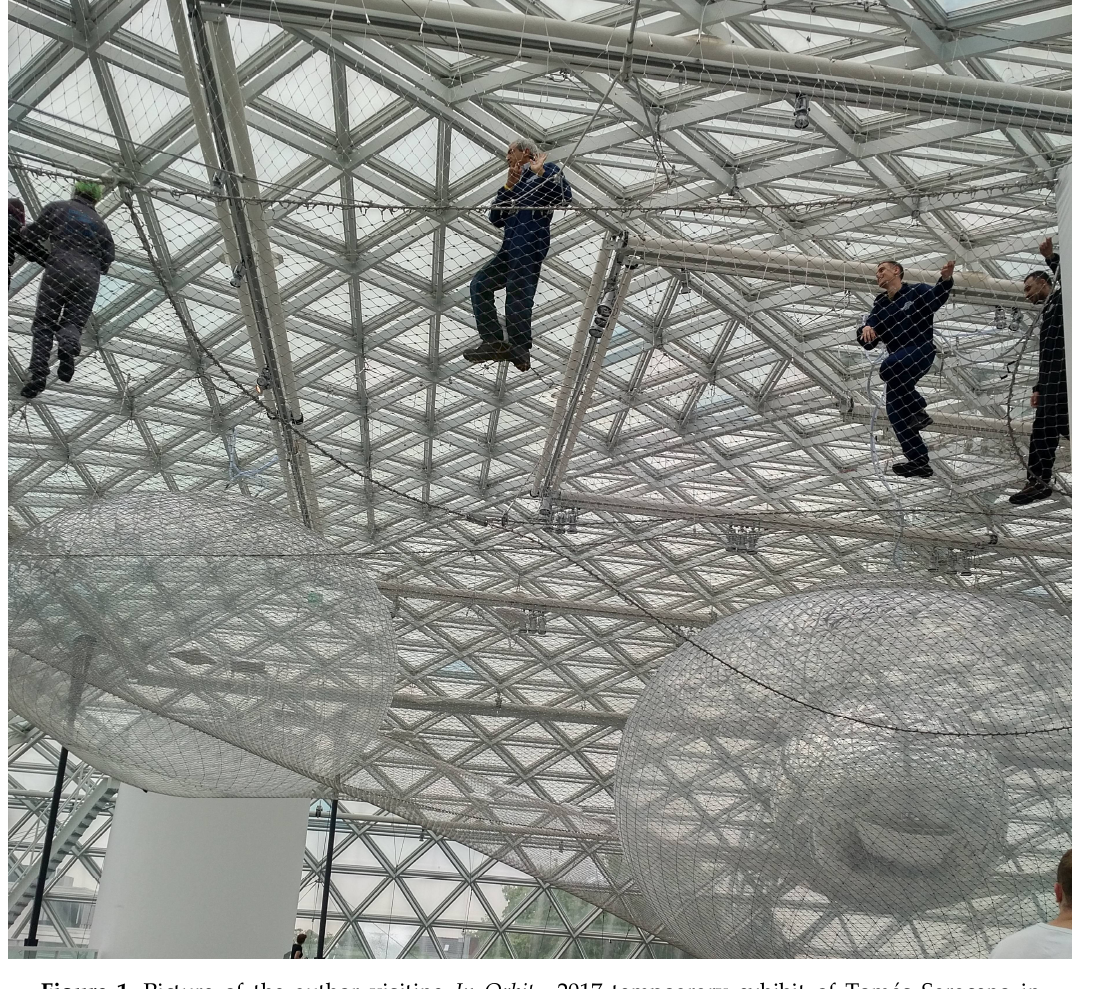
Figure 1. Picture of the author visiting In Orbit— 2017 tempoarary exhibit of Tomás Saraceno in Standenhaus, Kunstsammlung Nordrhein-Westfalen,